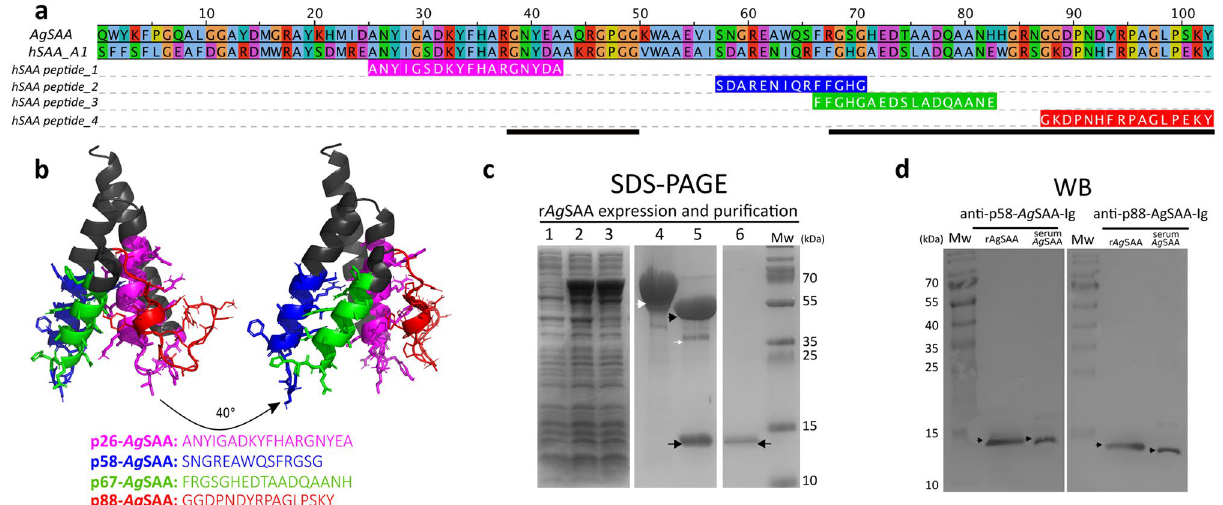
Figure 3. Identification of putative B-cell epitopes to the serum Ag SAA immunodetection. ( a ) Alignment of mature Ag SAA and hSAA1 (UniProtKB: P0DJI8) with four hSAA1 derived peptides (peptides 1–4) 64 . A. gueldenstaedtii homologues to these peptides were named p26- Ag SAA (aa 26–43), p58- Ag SAA (aa 58–71), p67- Ag SAA (aa 67–83) and p88- Ag SAA (aa 88–103). Black bars show putative Ag SAA B-cell epitopes predicted in silico (Bepipred algorithm). ( b ) Ag SAA structure model built with mSAA (PDB: 4Q5G) as template (SWISS- MODEL). Peptides p26- Ag SAA (pink), p58- Ag SAA (blue), p67- Ag SAA (green) and p88- Ag SAA (red) are indicated. Note that p58- Ag SAA and p88- Ag SAA are exposed at opposite sides of the protein. ( c ) Expression and purification of r Ag SAA in E. coli. Coomassie-stained SDS-PAGE-TRICINE corresponding the total fraction of an uninduced culture (lane 1), the total and soluble fractions of the IPTG-induced culture (lanes 2 and 3), the affinity-purified His-MBP- Ag SAA (lane 4), TEV-digested His-MBP- Ag SAA (lane 5) and pure r Ag SAA obtained after negative purification by IMAC followed by amylose affinity chromatography (lane 6). The band corresponding to His-MBP- Ag SAA (54.5 kDa, white head arrow), His-MBP (43.1 kDa, black head arrow), TEV SH (white arrow) and the band corresponding to r Ag SAA (11.4 kDa, black arrow) are indicated. Samples were run on three separated gels. The regions of interest in each gel were cropped, aligned using the Mw marker as a reference. The original gels are shown in Supplementary Figure S13. ( d ) Detection of r Ag SAA and native Ag SAA by Western blot. r Ag SAA, sturgeon serum and prestained Mw marker were run on SDS-PAGE gels and transferred to PVDF membranes. For blotting, membranes were cut and incubated separately with anti-p58- Ag SAA-Ig (dilution of 1:4000, 150 s exposure time) or anti-p88- Ag SAA-Ig (dilution 1:1500, 150 s exposure time). Figure shows the merge image of chemiluminescent and the prestained Mw marker images. Black head arrows indicate the signal band corresponding to Ag